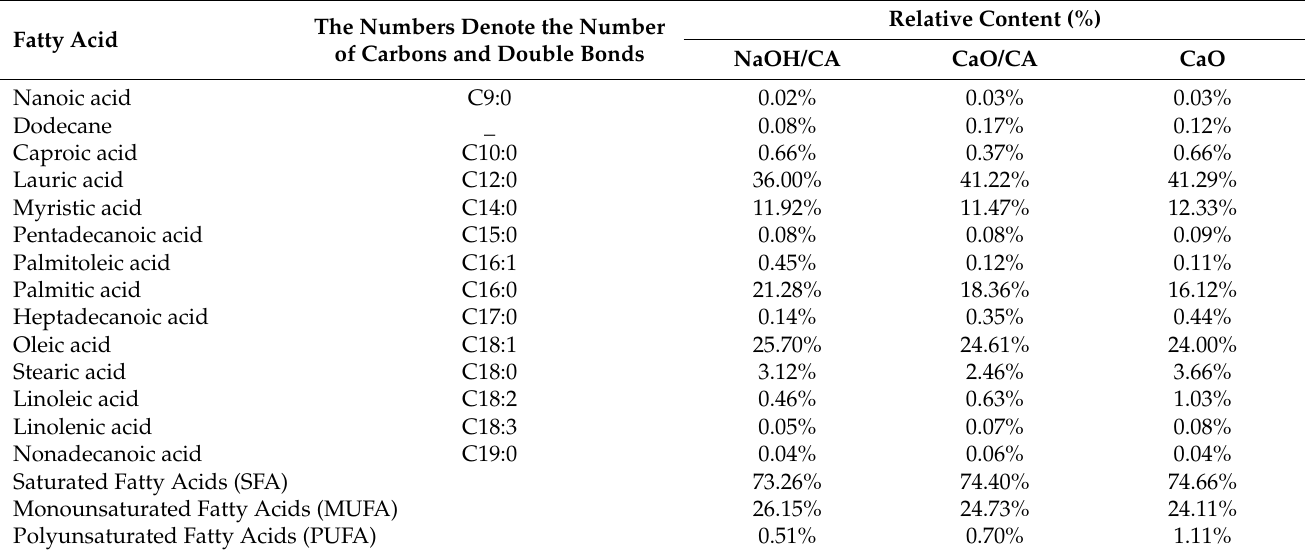
Table 4. Fatty acids composition of BSFL